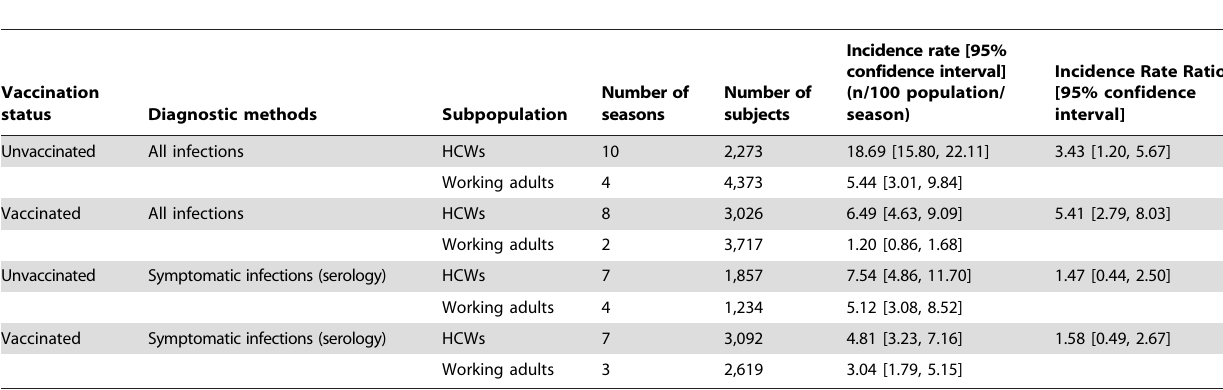
Table 2. Incidence rates and incidence rate ratios of influenza infection of healthcare workers and non-healthcare workers from subgroup meta-analyses, according to vaccination status and diagnostic